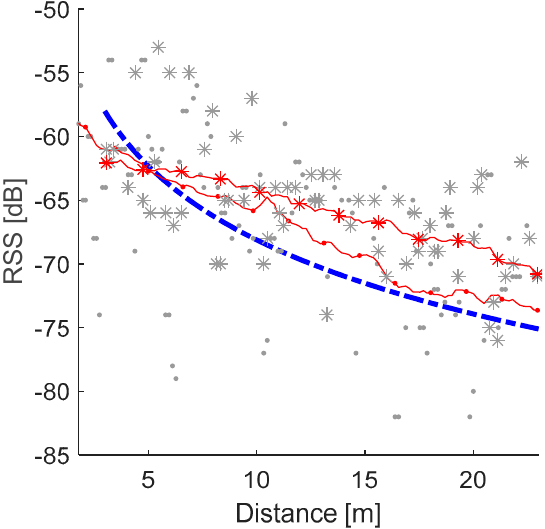
Figure 7. Relation between the RSS propagation model (dashed line) and RSS measured for two cows are represented by dots and asterisks (lines representing a filtered signal) walking with constant speed on a straight line in barn environment.